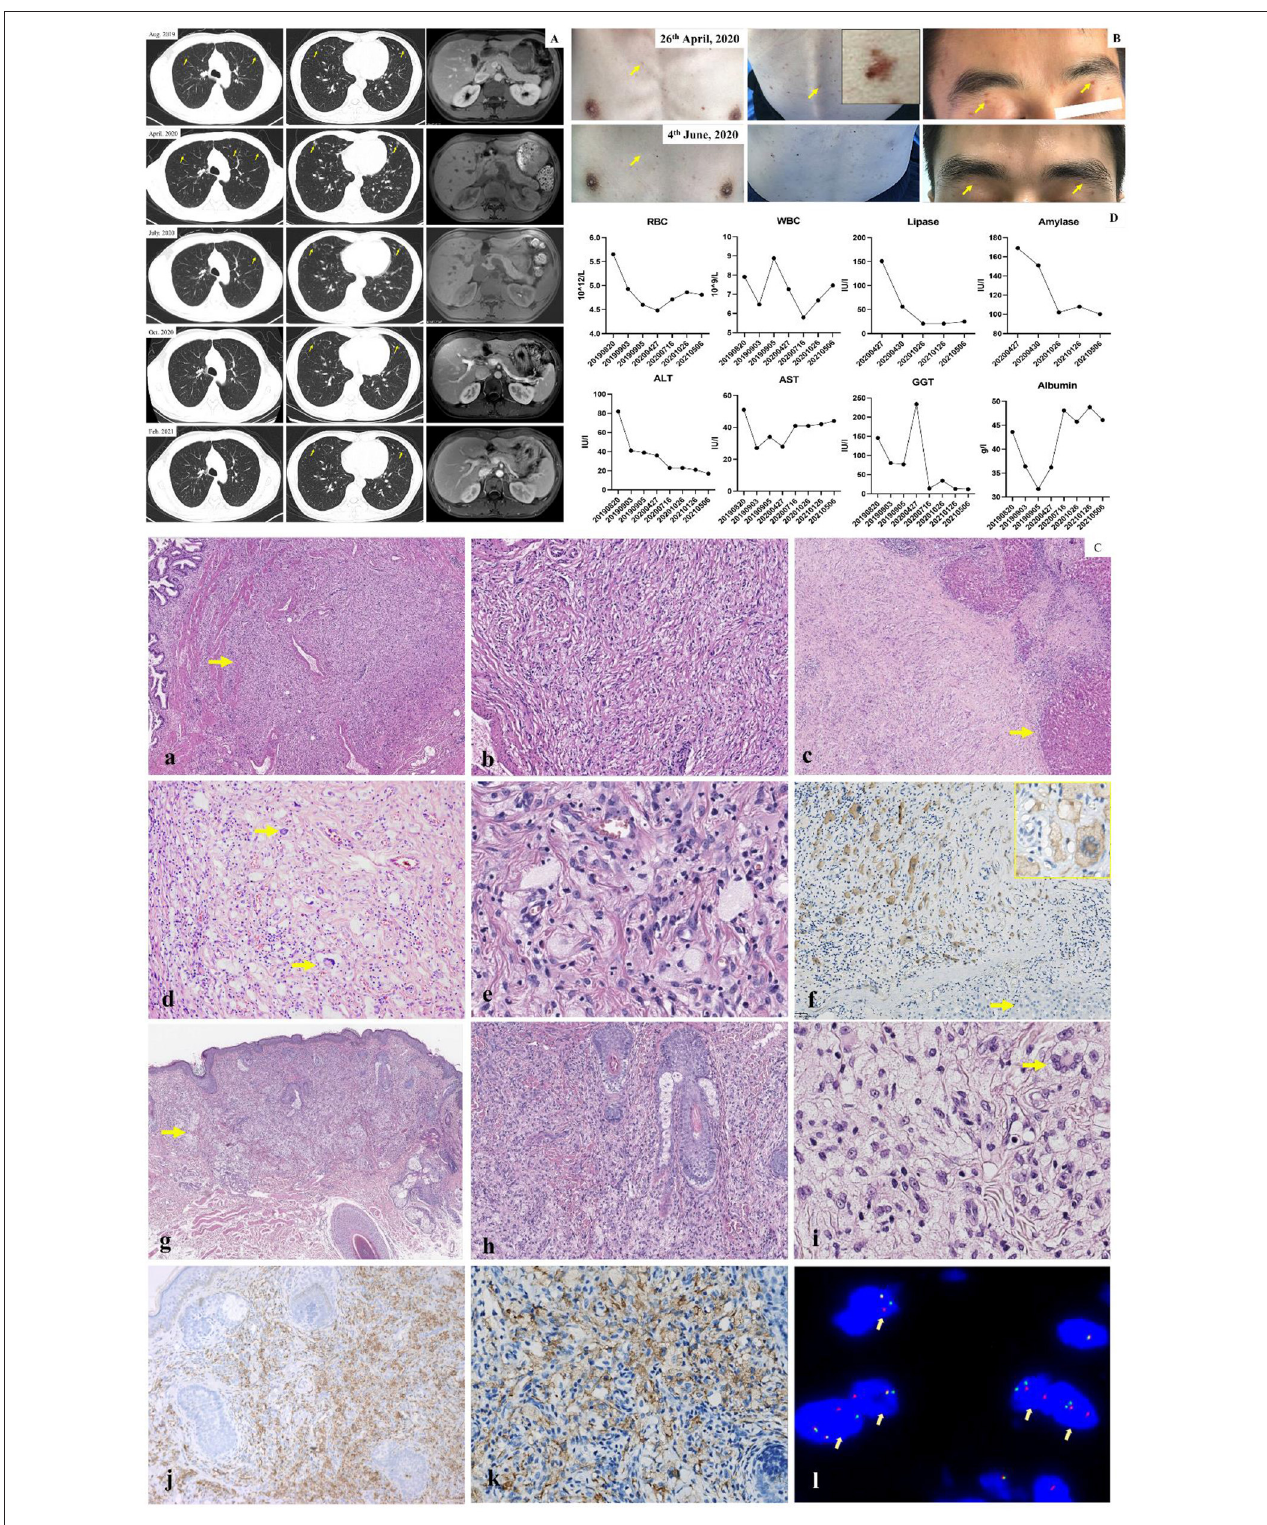
FIGURE 2 | (A) CT and MRI scan of lung and abdomen. CT and MR images showed pulmonary nodule (yellow arrow), liver, kidney and polypoid lesion of gallbladder from August 2019 to February 2021. The multinodules resolved significantly following alectinib treatment. (B) Observation of skin lesion. Before treatment,